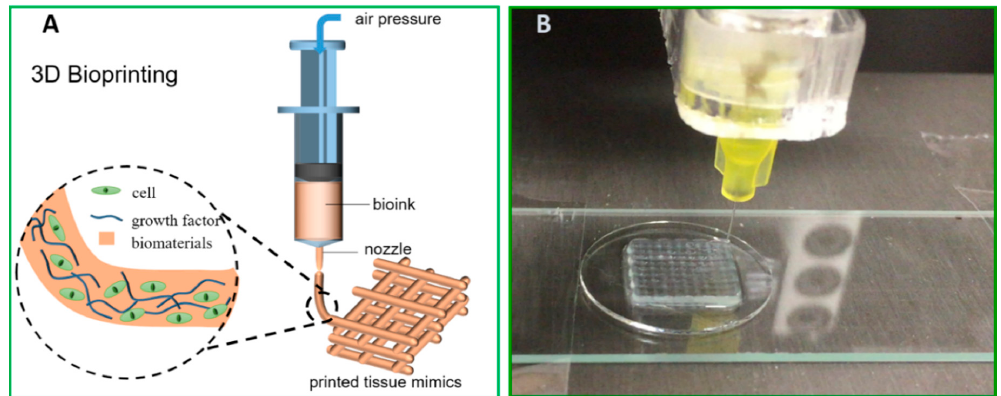
Figure 2. ( A ) Schematic illustration of direct ink writing (DIW) 3D bioprinting and ( B ) DIW printing of TEMPO-oxidised CNF ink at a dry matter content of 1 wt%.